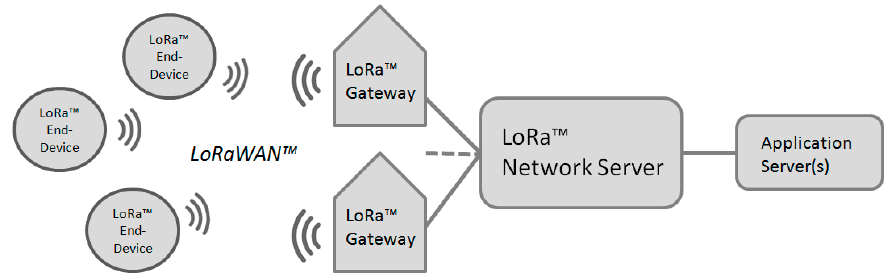
Figure 1. Long Range (LoRa) system components.